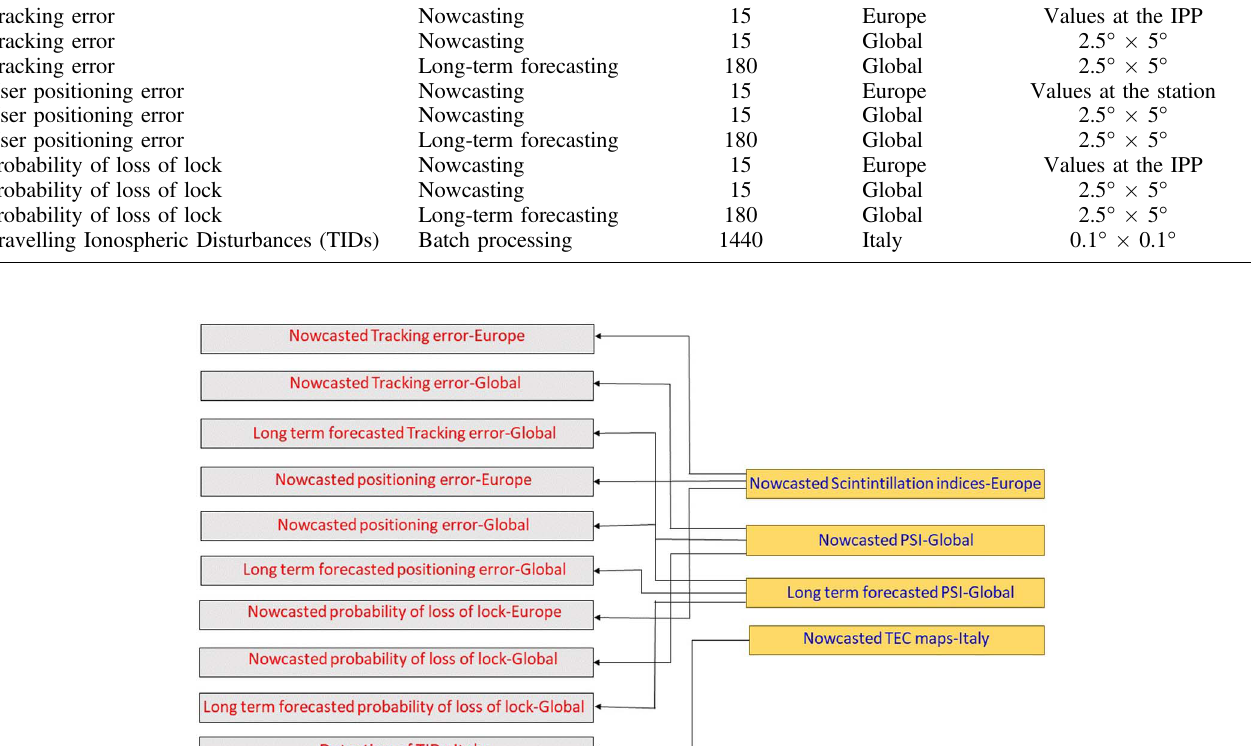
Table 5. List of the generated RPF 3 products along with the casting type, the refresh time, the coverage and the spatial resolution. Parameter